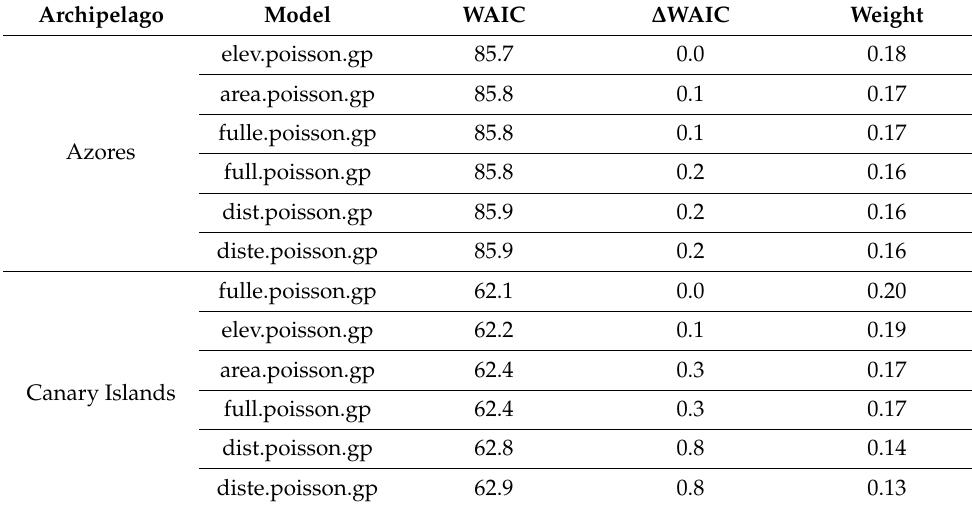
Table 7. Comparison of the several models using the “Widely Applicable Information Criterion” (WAIC) criterion for the native species. Only models with ‘weight’ greater than 0.01 are shown. See the captions of Tables 3 and 6 for the explanation of the acronyms.